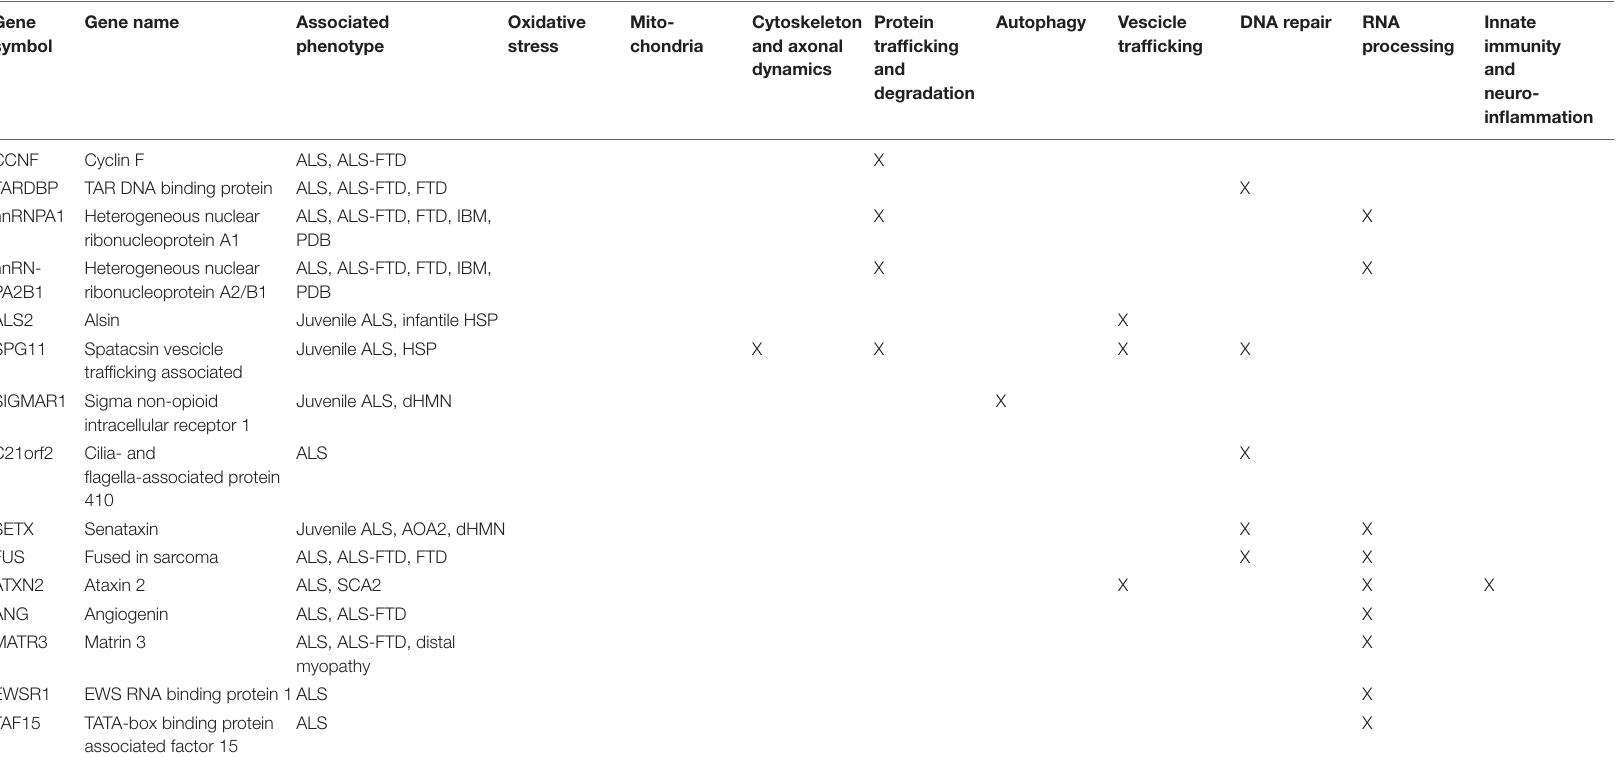
The table lists genes thought to be causative or risk factors for ALS sorted on the basis of their functional similarity. ALS, Amyotrophic lateral sclerosis; FTD, Frontotemporal dementia; PMA, Progressive muscular atrophy; IBM, Inclusion-body myositis; PDB, Paget disease of bone; HSP, Hereditary Spastic Paraplegia; dHMN, Distal Hereditary Motor Neuropathy; AOA2, Ataxia with oculomotor apraxia type 2; SCA2, Spinocerebellar ataxia type